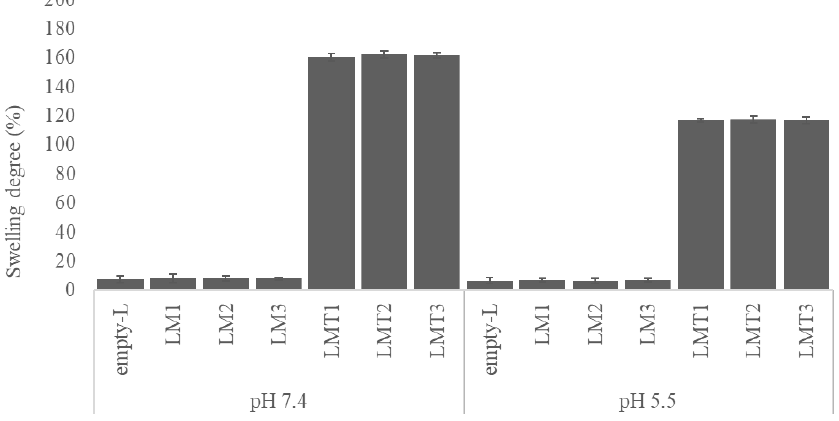
Figure 10. Swelling behavior of electrospun PLA-based nanofibers at pH 7.4 and 5.5.